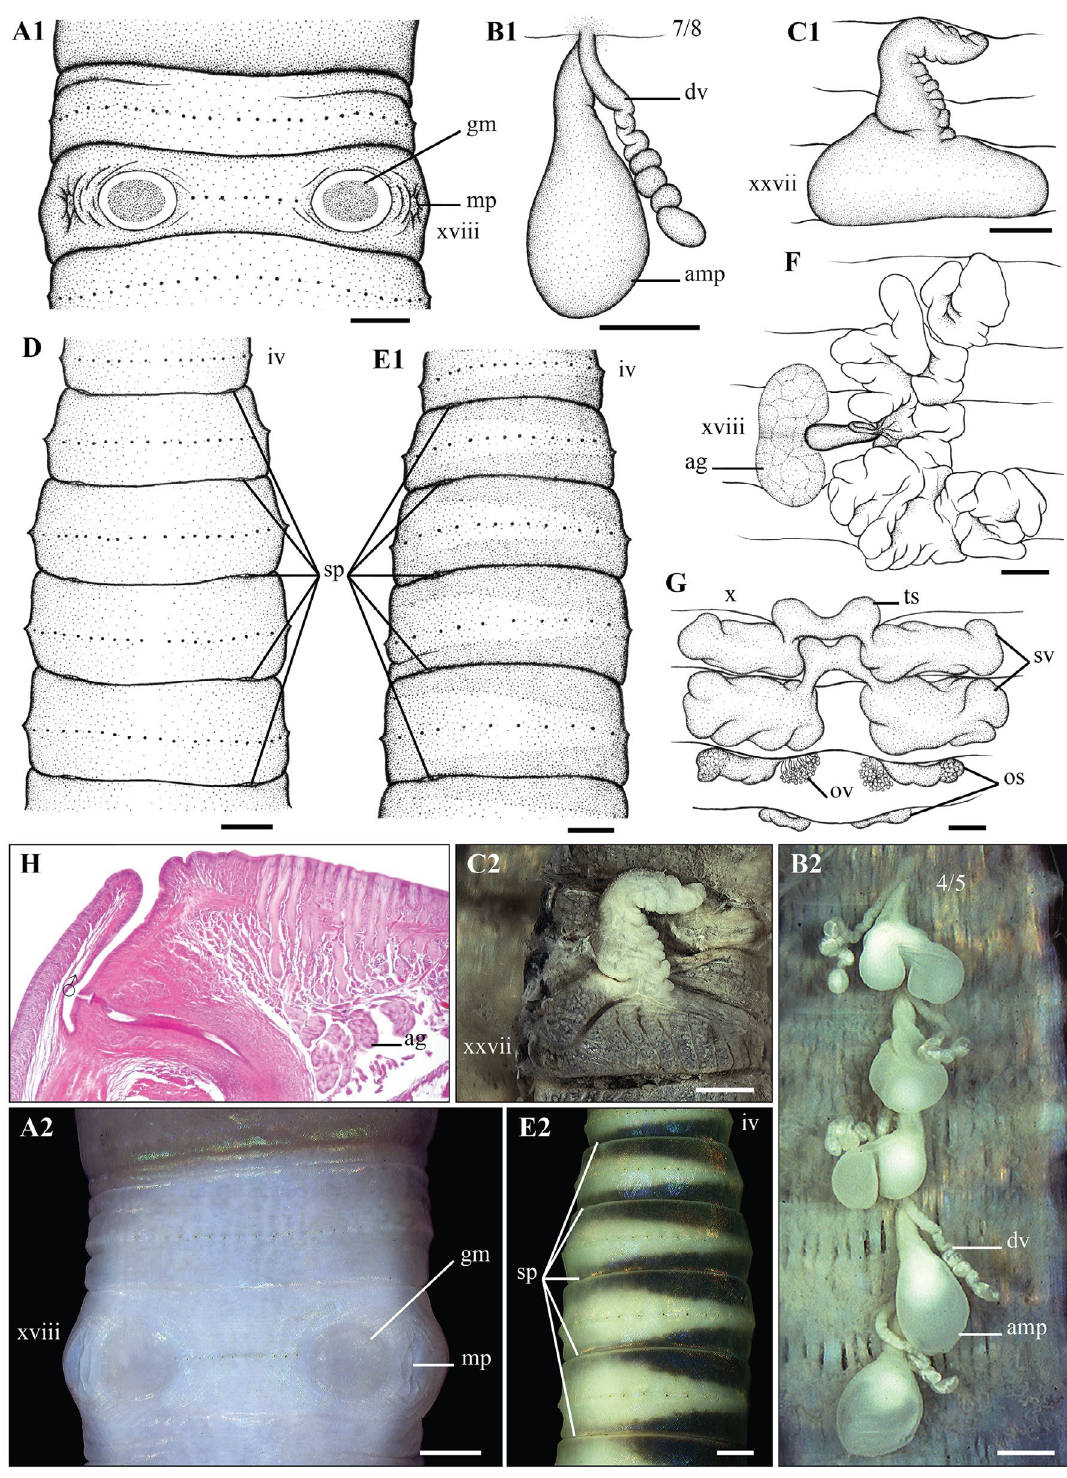
Fig. 2. Metaphire decemtheca sp. nov., holotype (CTU-EW.183.h01). A1, A2 . Ventral view of male pore region. B1, B2 . Right spermathecae. C1, C2 . Intestinal caecum. D . Ventral view of spermathecal pore region. E1, E2 . Lateral view of spermathecal pores region. F1, F2 . Left prostatic gland. G . Testis sacs and seminal vesicles. H . Male pore region transverse body section. Scale bars = 1